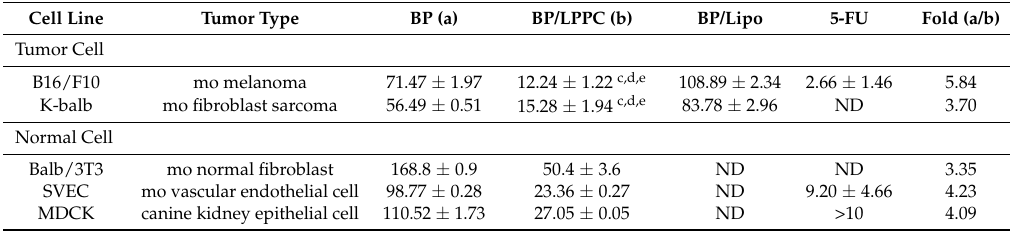
Values revealed mean ± SD ( µ g/mL) at 24 h. BP/Lipo: BP/Liposome. ND: Non-Detection. SVEC: mouse endothelial cell. MDCK: canis kidney epithelial cell. a: IC 50 of BP. b: IC 50 of BP/LPPC. c : p < 0.05 BP/LPPC group versus BP group. d : p < 0.05 BP/LPPC group versus BP/Lipo group. e : p < 0.05 Tumor cells versus normal cells in BP/LPPC group.